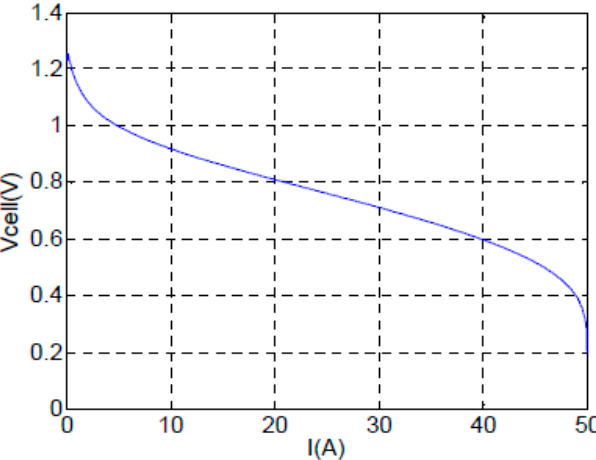
Figure 3. Typical voltage–current characteristic of HFC.